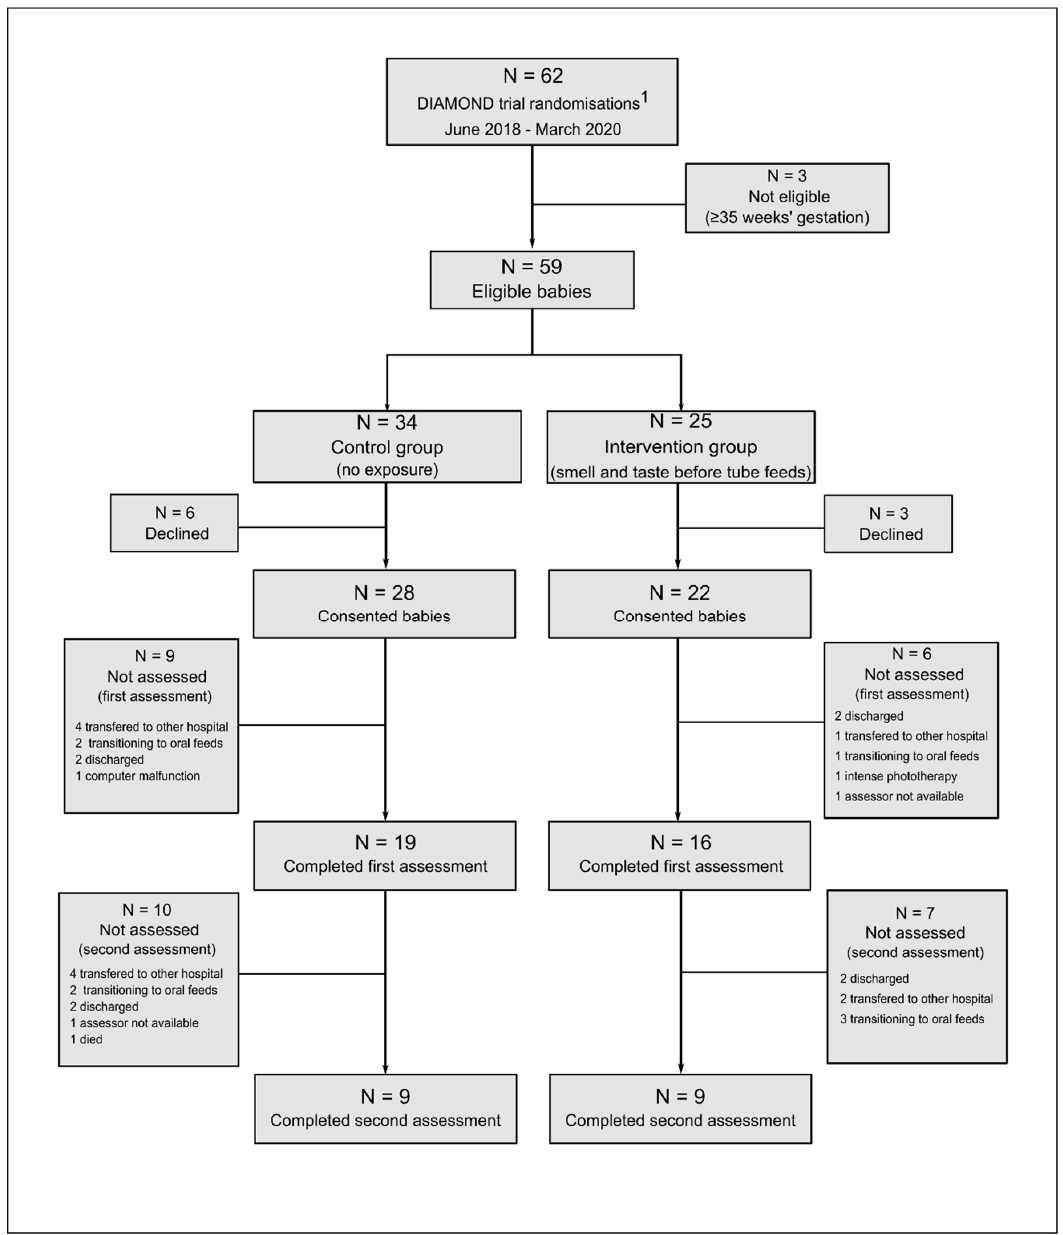
Figure 3. Study flowchart. 1 Total recruited at Auckland City Hospital during the study period. Table 1. Study groups’ characteristics.